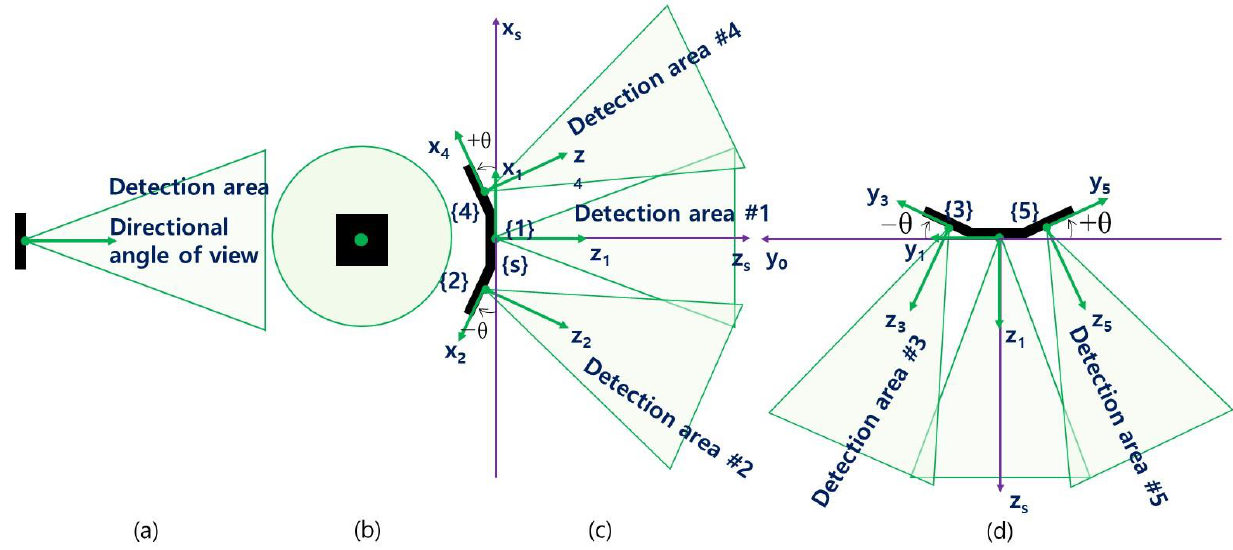
Figure 5. The angle of view and detection area of the ultrasonic sensor system: ( a , b ) are side and front views, respectively, of a single 3D ultrasonic sensor module, ( c , d ) are side and top cross-sectional views, respectively, of multiple 3D ultrasonic sensor modules